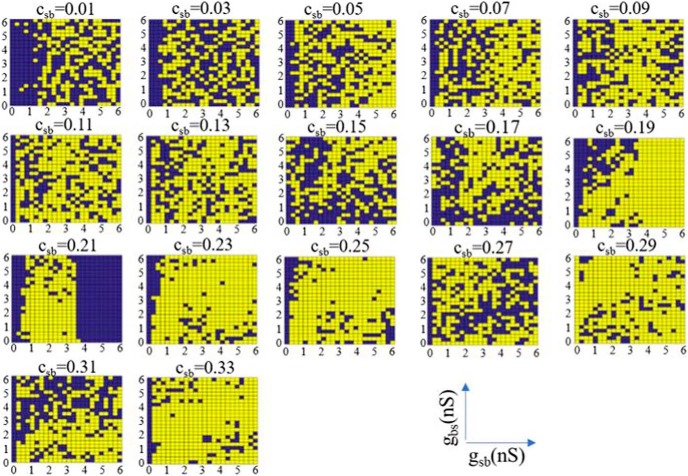
All selected and rejected parameter sets. Parameter sets are considered as selected (purple) if computed LFPs match LFPs from experiment in polarity and frequency (3-Hz lower bound). Otherwise, as rejected (yellow). A clear separation in parameter space occurs for csb = 0.21.